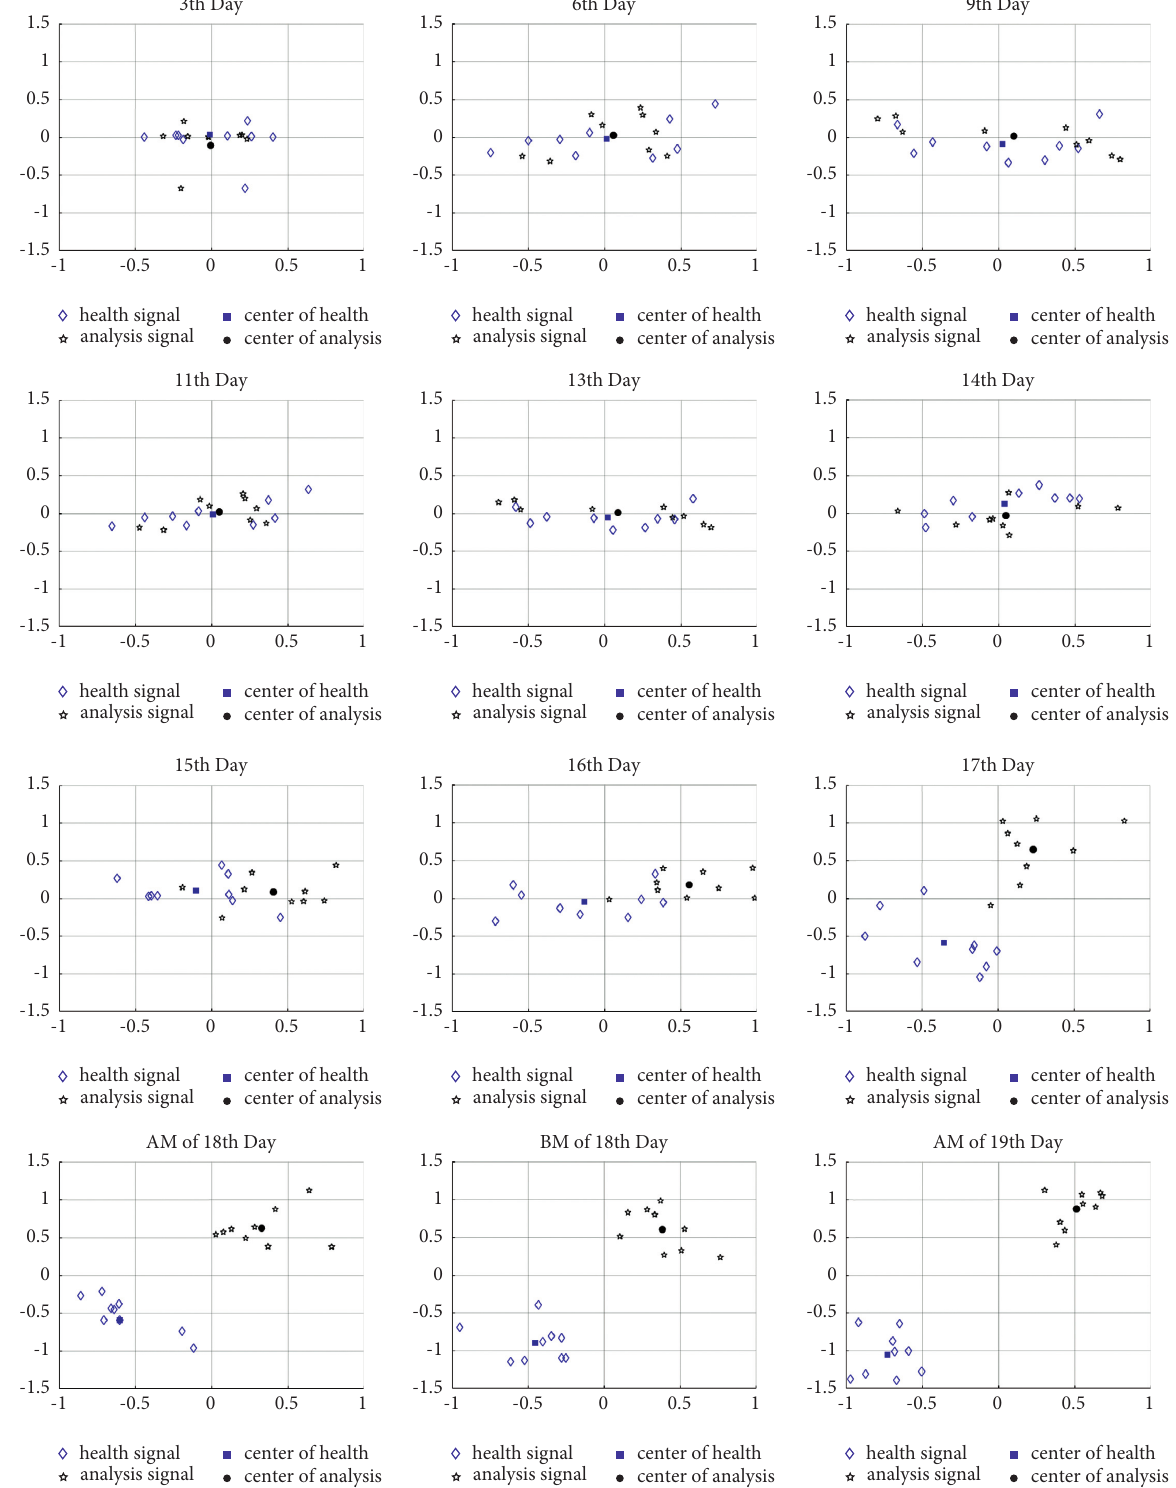
Figure 10: Centroid of